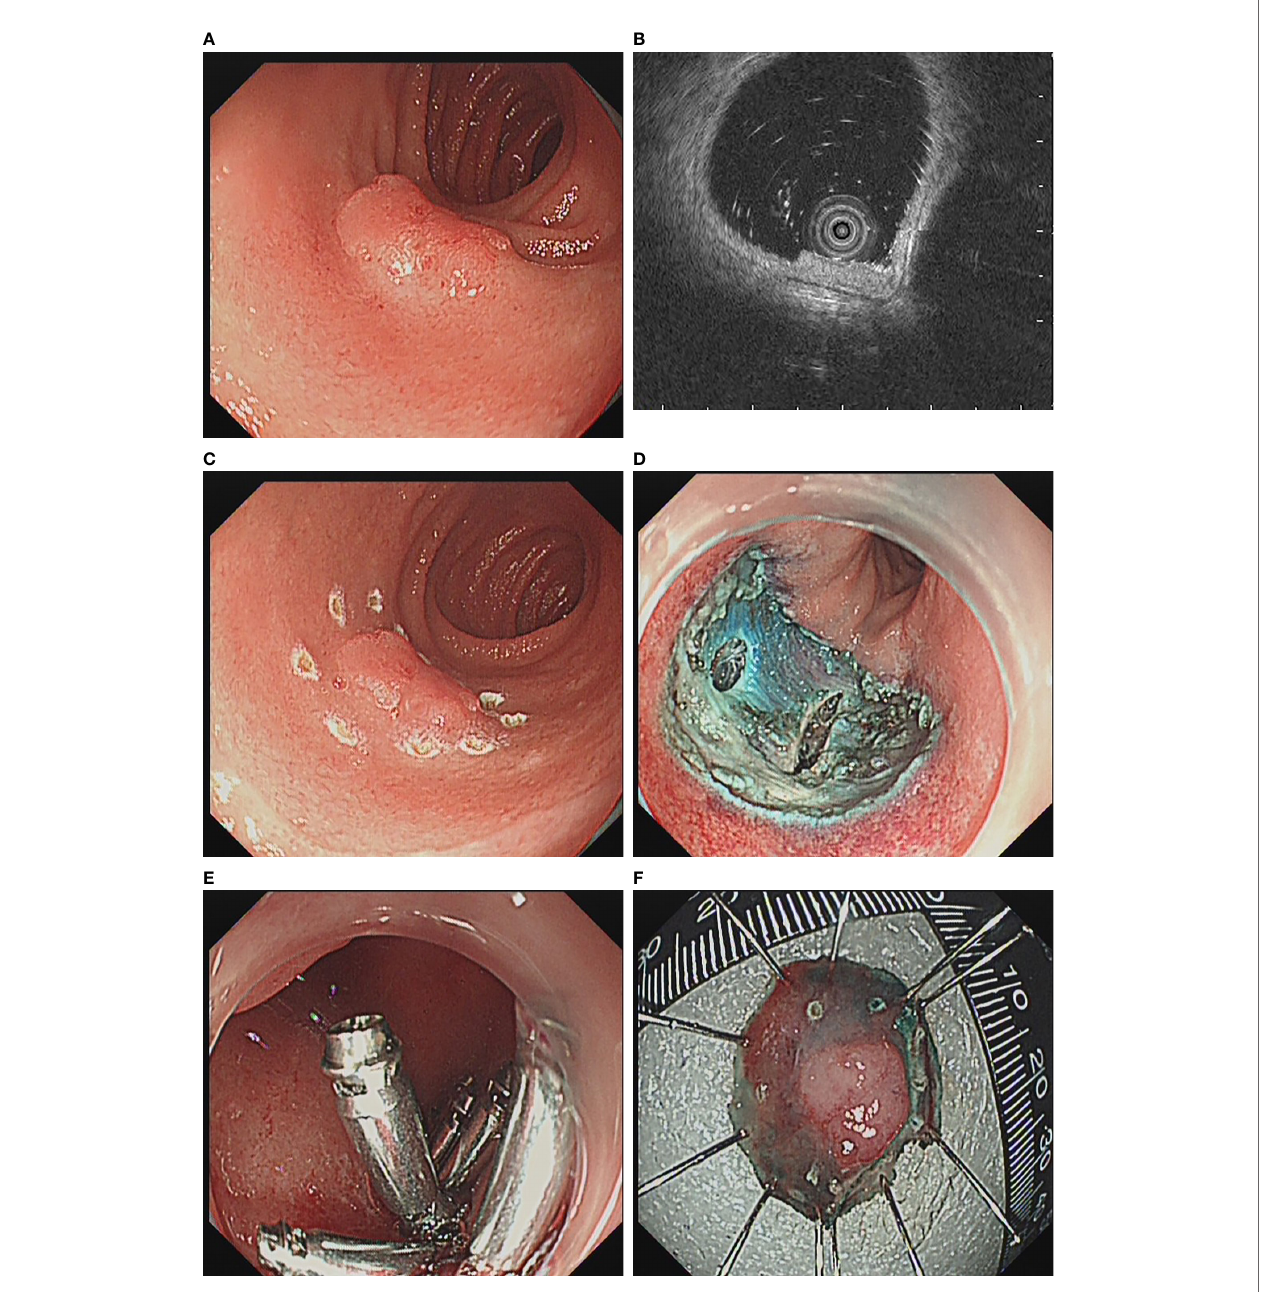
FIGURE 2 | ESD for duodenal bulb lesions. (A) Lesion at the duodenal bulb; (B) Endoscopic ultrasonography revealed that the lesion was con fi ned to the mucosal layer; (C) Dual knife was used to mark around the lesion; (D) Wound after lesion resection; (E) Close the wound with a metal clip; (F) Lesion after